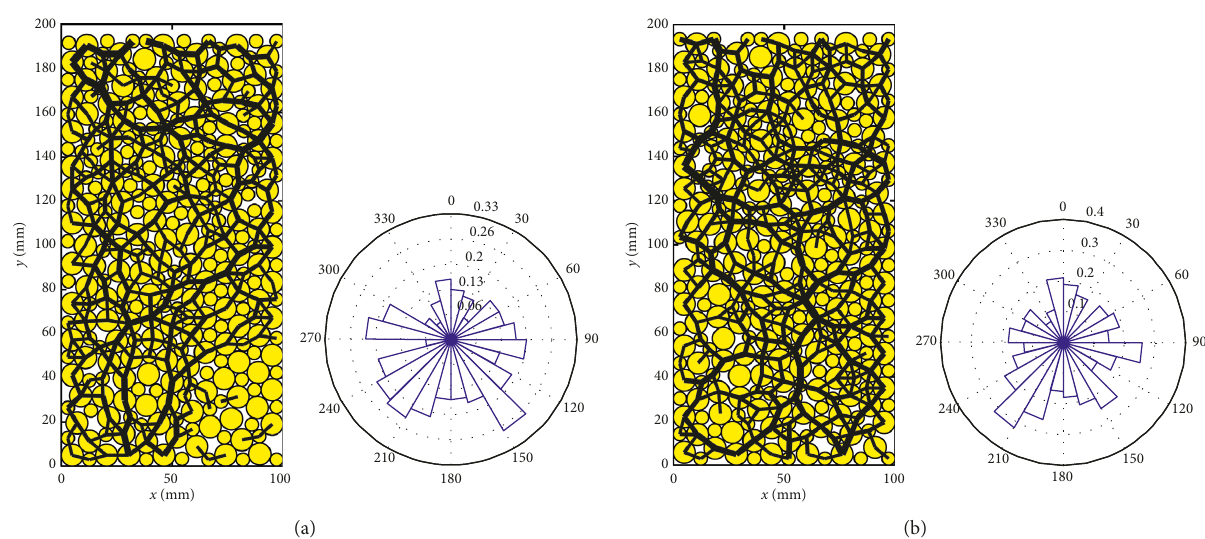
Figure 13: Distribution of force chain and force angle for bonded particles in the DEM modelling, under the lever weights of (a) 0.5kg and (b) 2.0 kg.